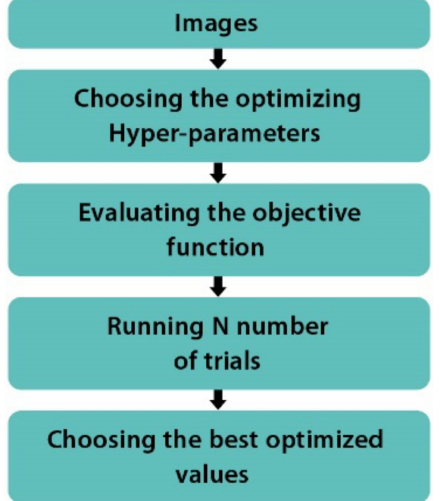
Figure 6. The flow of Bayesian